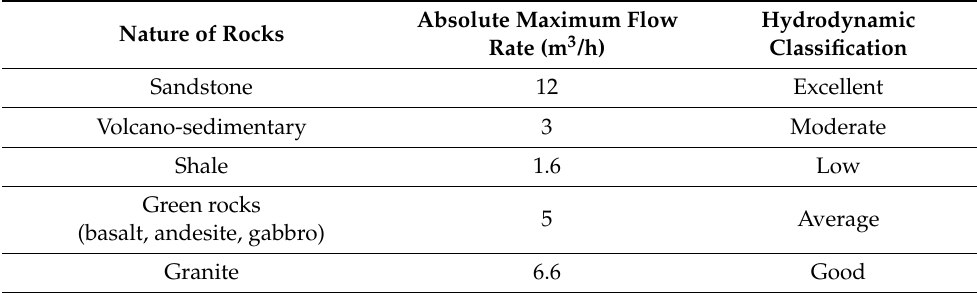
Table 1. Influence of geology on the flow rate of